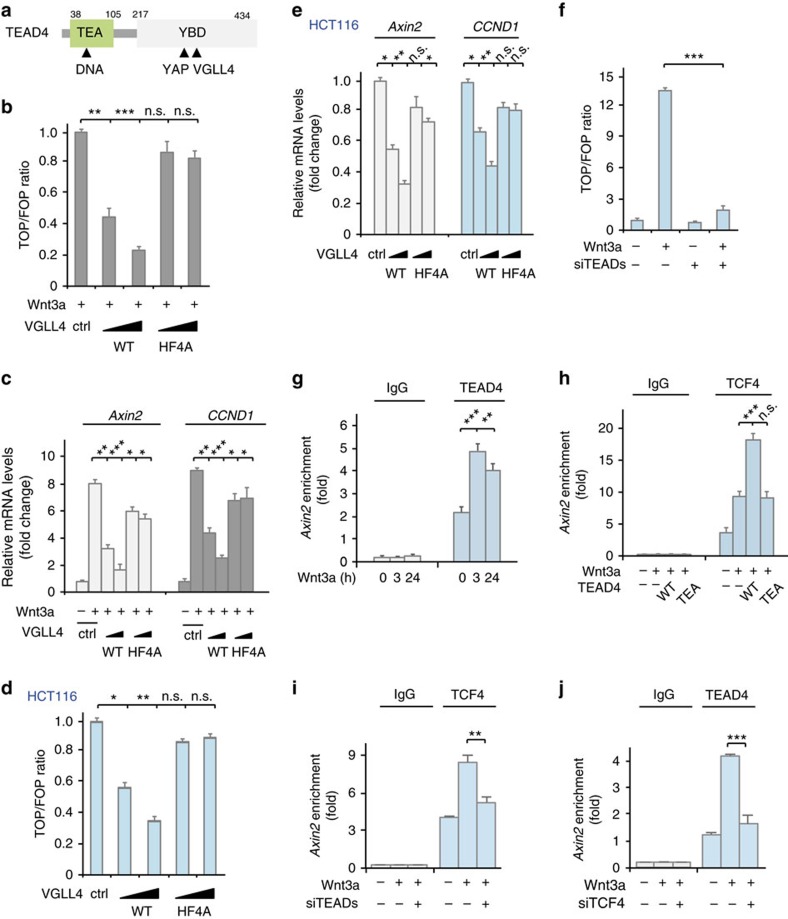
VGLL4 inhibition of Wnt signalling depends on a TEAD4-TCF4 interplay.(a) Schematic illustration of the domain organization for human TEAD4. Amino acid numbering is according to human TEAD4. (b,c) A VGLL4 mutant (HF4A) defective in binding TEAD failed to inhibit TOP-FLASH activity (b) and transcription of Wnt target genes (c) in HEK293T cells treated with Wnt3a. (d,e) The VGLL4 mutant (HF4A) did not inhibit TOP-FLASH activity (d) and transcription of Wnt target genes (e) in HCT116 cells. (f) Knockdown of TEADs (TEAD1, 2, 3, 4) inhibited TOP-FLASH reporter activity in Wnt3a-treated HEK293T cells. (g,h) Chromatin was immunoprecipitated with the TEAD4 antibody (g) or TCF4 antibody (h) followed by qPCR using primer pairs spanning the human Axin2 locus. Results are presented as percentage immunoprecipitated over input and are representative of three independent experiments. (i,j) ChIP-qPCR showing TCF4/TEAD4 binding to the Axin2 promoter in 293T cells transfected with control siRNA, TCF4 siRNA (siTCF4s) or TEADs siRNAs (siTEADs) with the TCF4 antibody (i) or TEAD4 antibody (j). Note: Data in b–j represent the mean±s.d. from one experiment. Experiments we repeated three times. Unpaired t tests were used to compare the difference between groups. *P<0.05, **P<0.01, ***P<0.001, significant relative to control. n.s., no statistics significance. HF4A, a VGLL4 mutant in which amino acids H212, F213, H240 and F241 were substituted with alanines. GFP-TEA, GFP-tagged TEAD4 TEA domain (Supplementary Fig. 6).